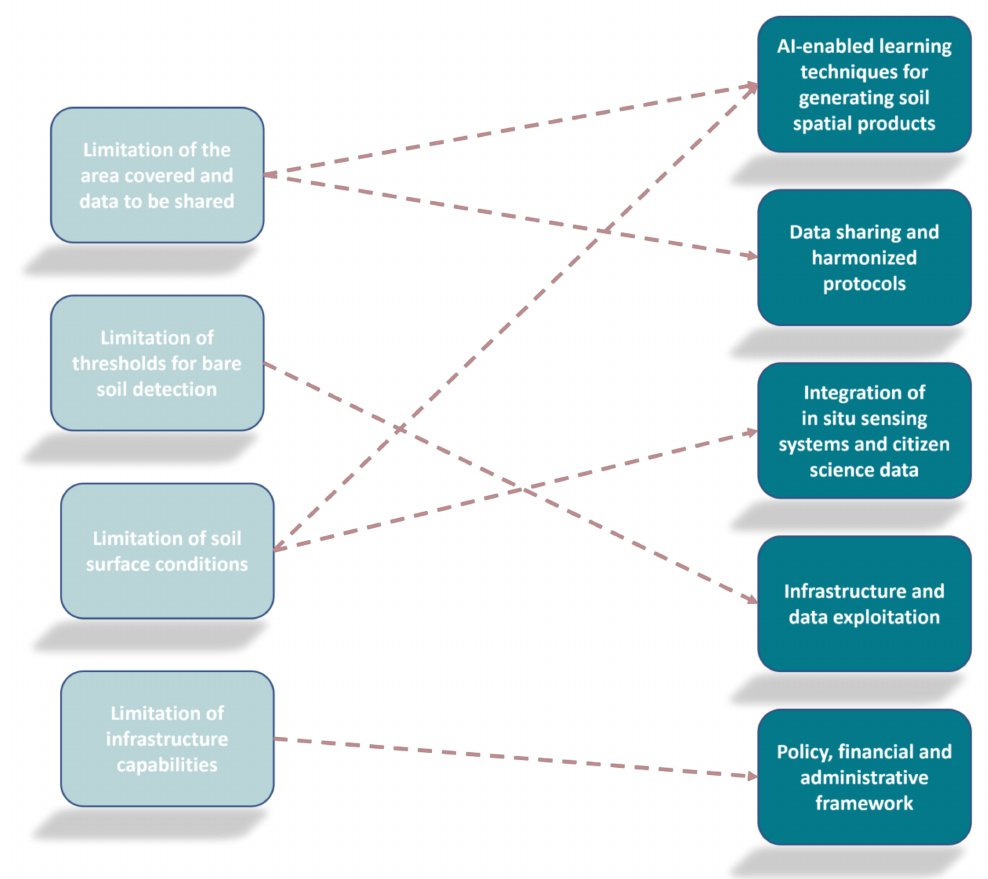
Figure 9. Interlinkages of the recognized current limitations with the proposed future direction in order to reach the final